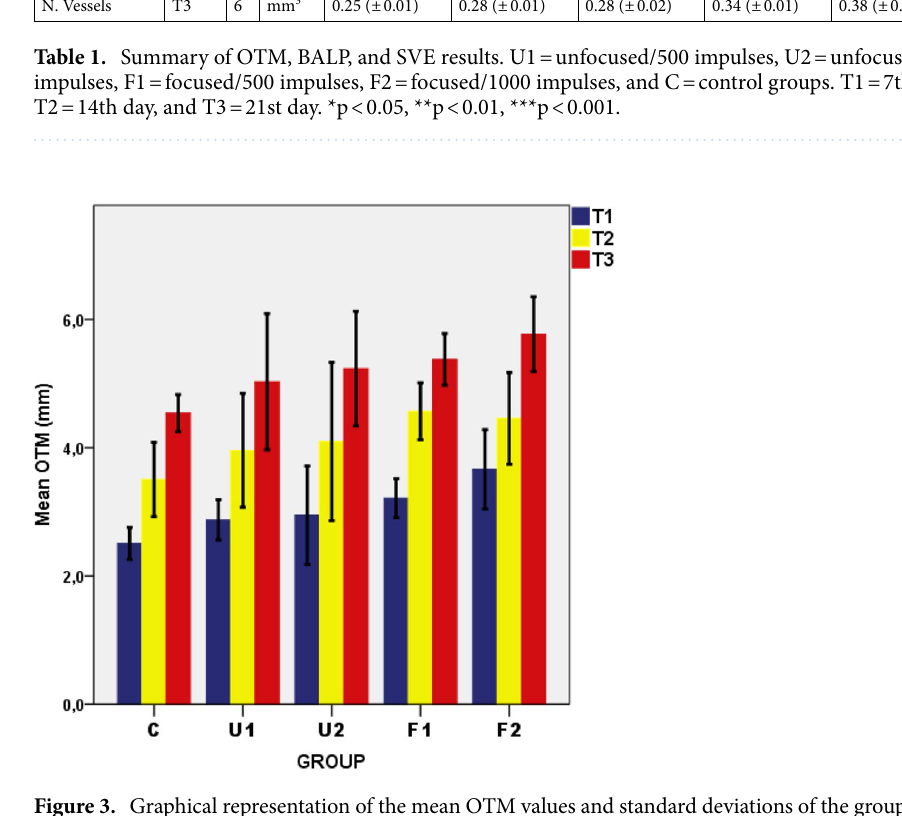
Figure 3. Graphical representation of the mean OTM values and standard deviations of the groups in three time